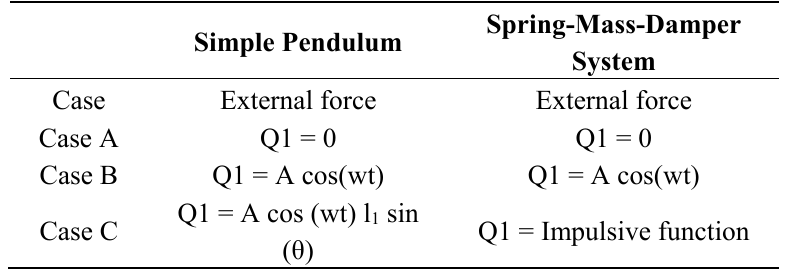
Table 1. Simulated cases.